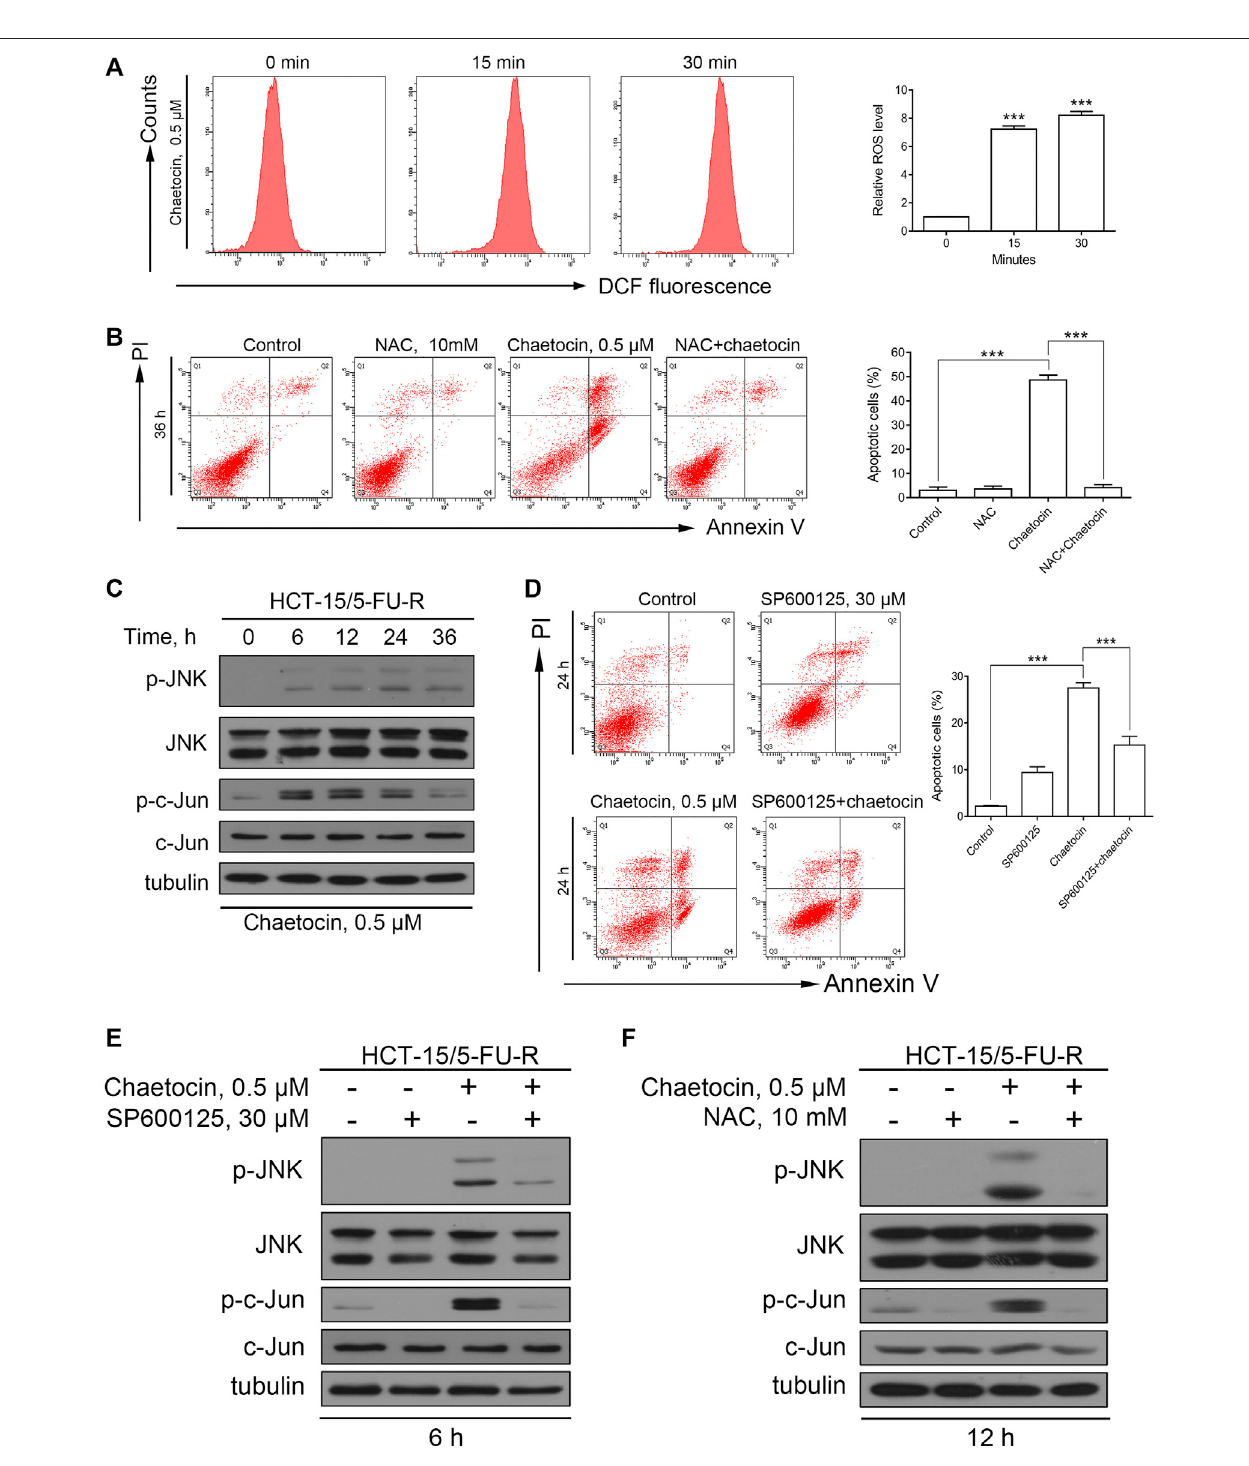
FIGURE 6 | Chaetocin-induced apoptosis in HCT-15/5FU-R cells is associated with the ROS/JNK/c-Jun pathway. (A) The ROS levels of HCT-15/5FU-R cells. Resultswereshownasmean ± SDofthreeindependentexperiments.*** p < 0.001,versuscontrolgroup. (B) HCT-15/5FU-Rcellsapoptosisinducedbychaetocinwere rescuedby2 hofNACpretreatment(*** p < 0.001). (C) TheexpressionlevelJNKandc-Junproteinin5-FU-resistantCRCcellsbywesternblotafterchaetocintreatment. (D) HCT-15/5FU-R cells were cotreated with chaetocin for 24 h after 2 h SP600125 preincubation. Flow cytometry were used analyze the rescued population (*** p < 0.001). (E) After pretreated with SP600125 for 2 h and then cotreated with chaetocin for another 6 h, the expression of JNK and c-Jun in HCT-15/5FU-R cells wereanalyzedbywesternblot. (F) TheexpressionlevelsofJNKandc-JuninHCT-15/5FU-Rcellswereevaluatedbywesternblotafter2 hofNACpretreatmentfollowed by chaetocin cotreatment for 12